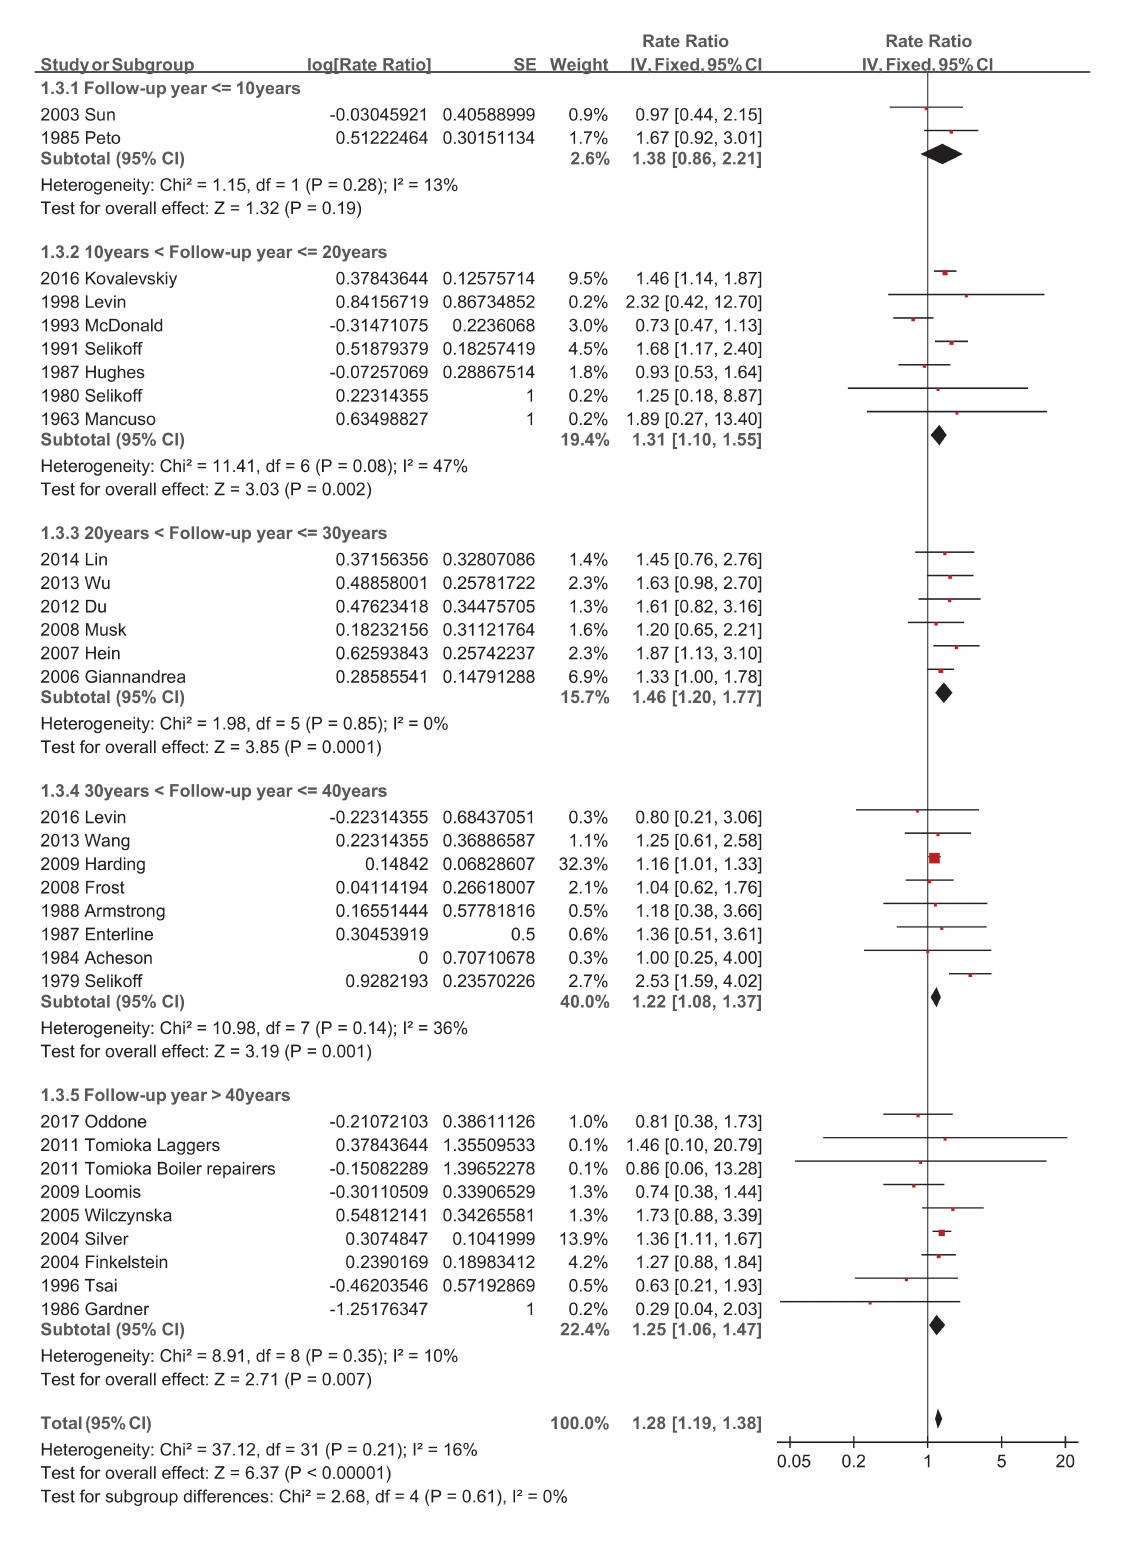
Figure 5. Subgroup analysis of SMRs of esophageal cancer based on follow-up